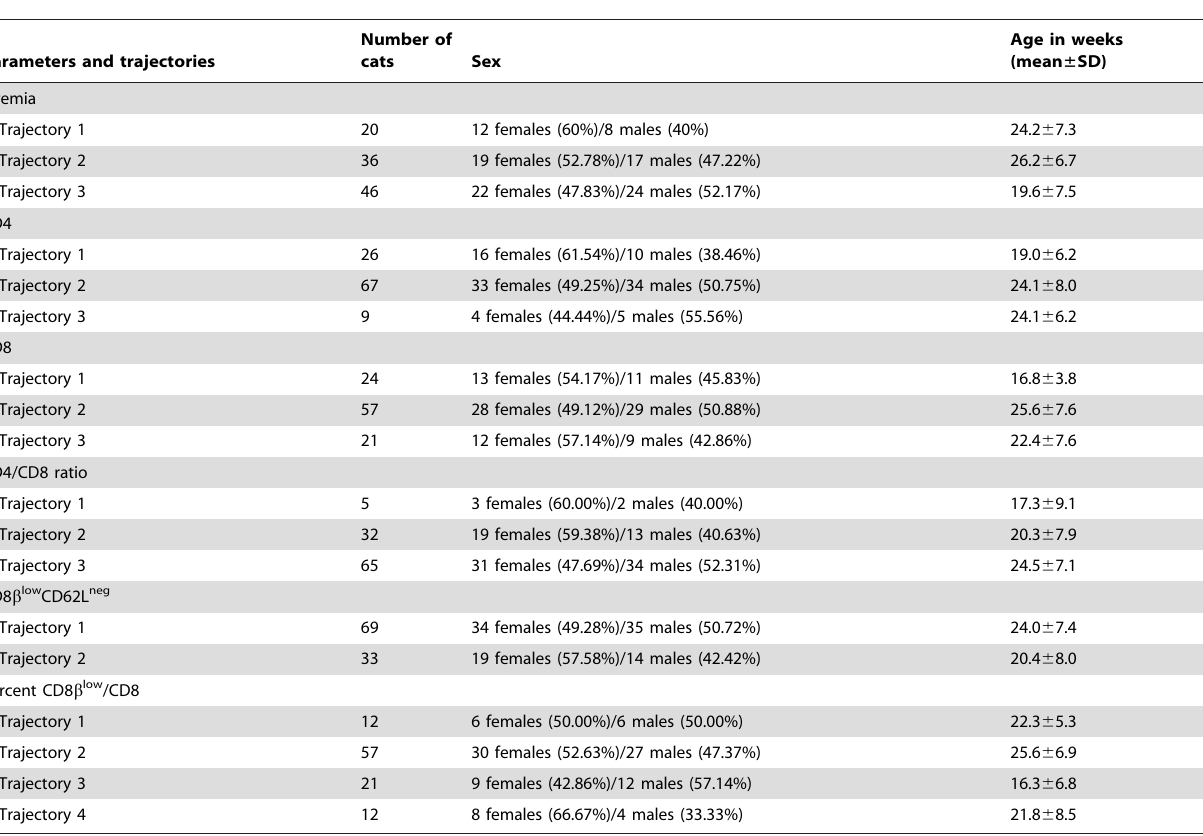
Table 4. Sex and age of cats by trajectory group for viremia and changes in T-cell markers.